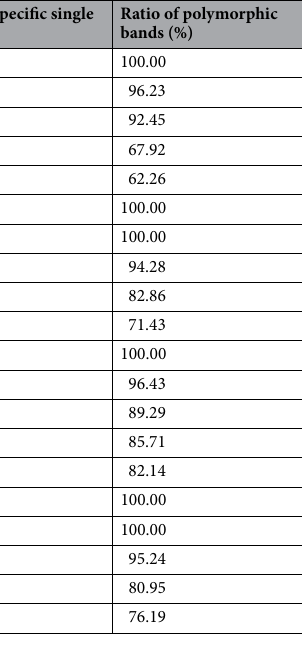
Table 5. Genetic variation in different varieties after aging treatment.